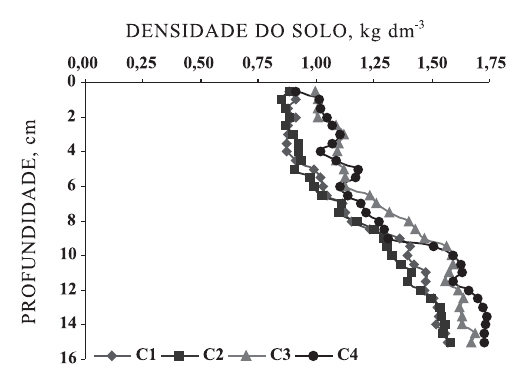
Figura 5. Perfil da densidade média do solo obtida por tomografia computadorizada para o teor de água do solo U = 0,31 kg kg -1 , em razão das cargas